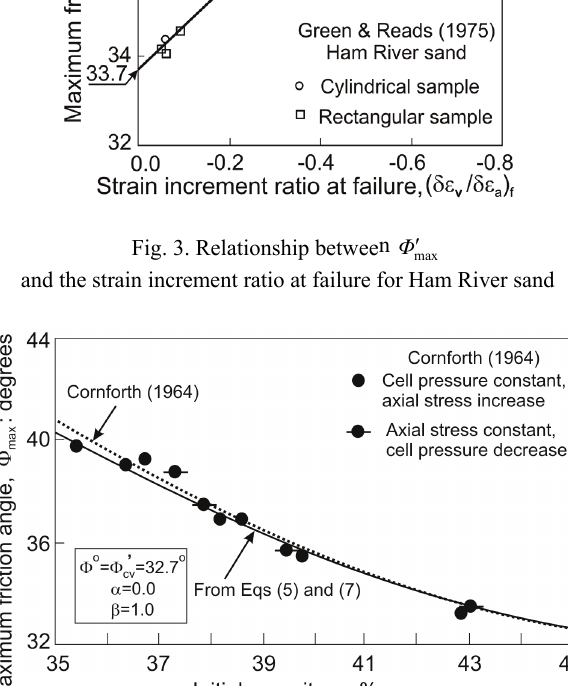
Fig. 4. Strength of Brasted sand at different initial porosities in drained triaxial compression tests